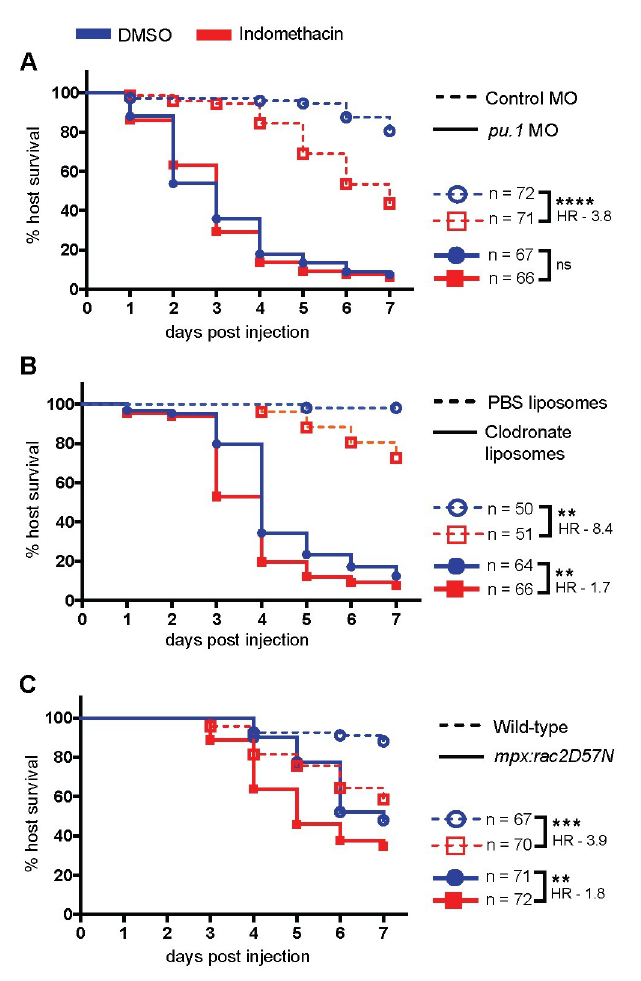
Fig 2. Cyclooxygenase-mediated host protection depends on phagocytes. Survival of larvae injected with TBK1.1 (Af293) spores at 2 dpf. (A) Development of phagocytes was inhibited by pu . 1 morpholino (MO). Control larvae received standard control MO. (B) Macrophages were depleted via clodronate liposome i.v. injection at 1 dpf. Control larvae received PBS liposomes. (C) Neutrophil-defective larvae ( mpx : rac2D57N ) were compared to wild-type larvae. Data are pooled from three independent replicates, at least 10 larvae per condition, per replicate and the total larval N per condition is indicated in each figure. Cox proportional hazard regression analysis was used to calculate P values and hazard ratios (HR). Average injection CFUs: (A) control MO = 25, pu . 1 MO = 24, (B) PBS liposomes = 20, clodronate liposomes = 23, (C) wild-type = 26, mpx : rac2D57N =